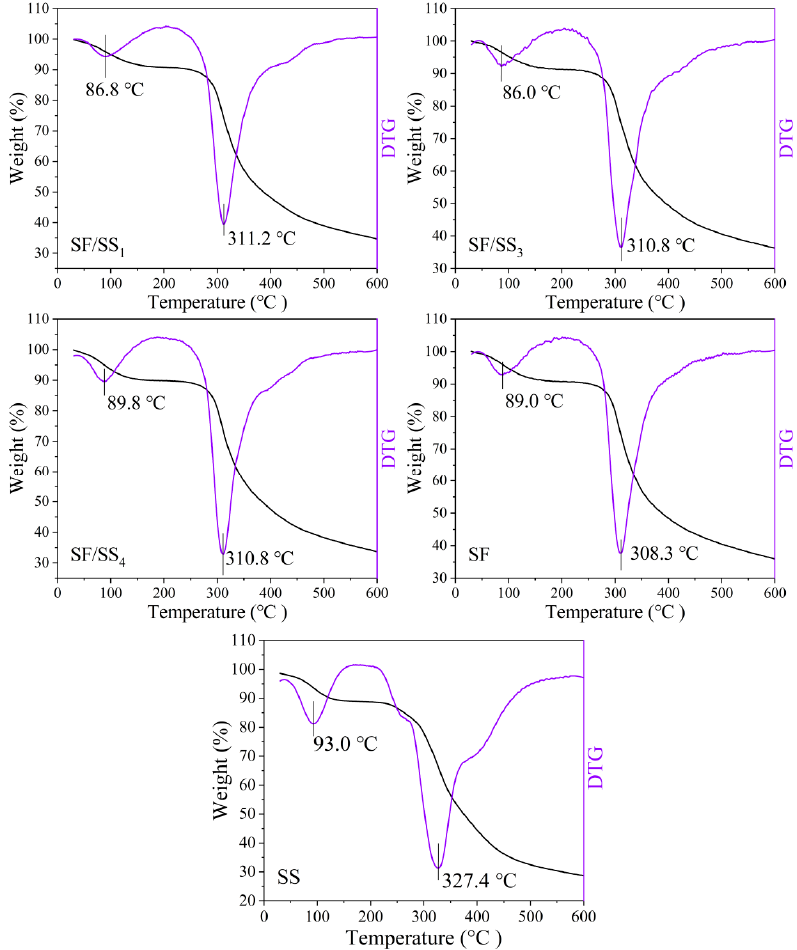
Figure 7. TG-DTG curve of SF/SS composite films.